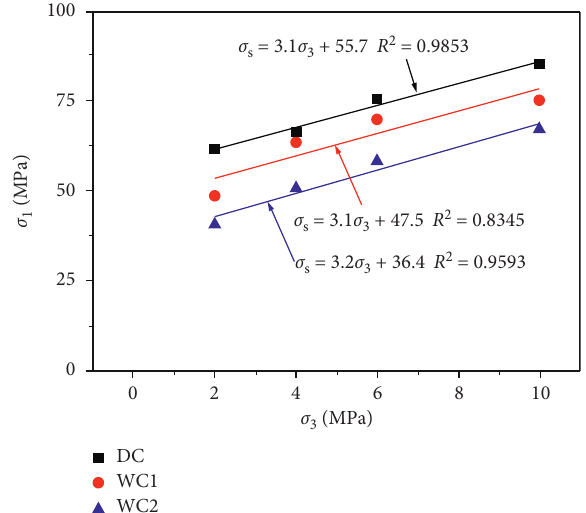
Figure 13: The functional relation between confining pressure and